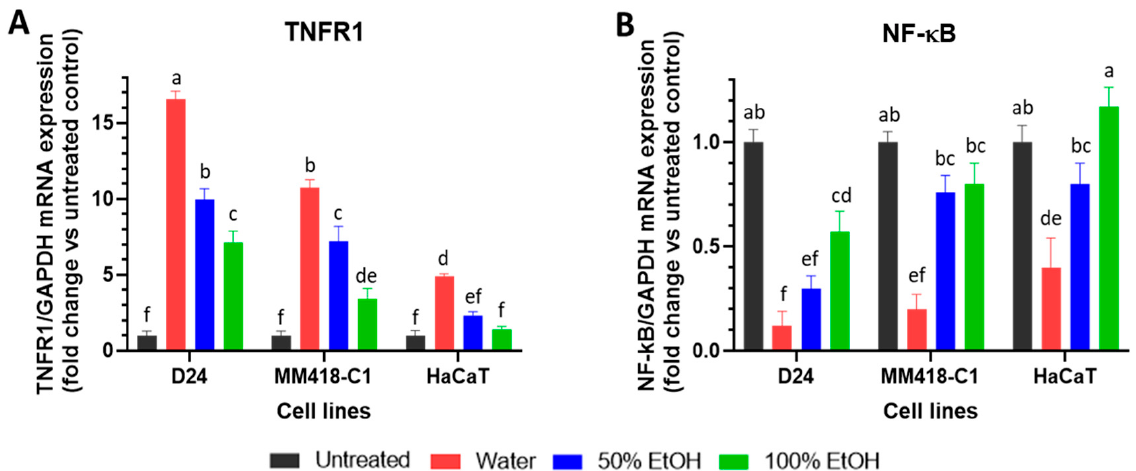
Figure 4. Effect of M. cochinchinensis seed extracts on the expression of. TNFR1 ( A ) and NF-kB ( B ) mRNA in D24 and MM418-C1 melanoma and HaCaT cells. The cells were treated with 100 µg/mL of the different seed extracts for 48 h prior to RNA collection. Results were presented as the fold change compared to untreated controls ± SEM ( n = 3), different letters indicated statistical significance at p ≤ 0.05 between different treatments (Analysis by One-way ANOVA with Turkey’s LSD test). The upregulation of TNFR1 can trigger both cell survival and apoptosis [32]. If